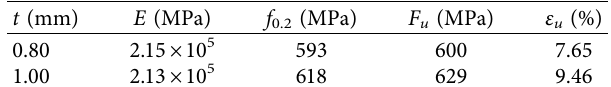
Figure 6: Instrumentation arrangement. (a) Position transducers for the specimen without holes. (b) Strain gauges for the specimen without holes. (c) Position transducers at midheight for the specimen with holes. (d) Strain gauges at midheight for the specimen with holes. (e) Position transducers at about 50mm higher than the midheight for the specimen with holes. (f) Strain gauges at about 100mm higher than the midheight for the specimen with holes. Table 3: Mean value of coupon